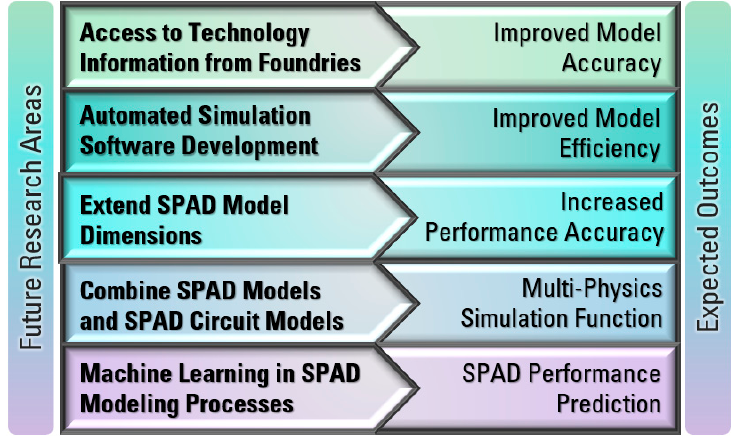
Figure 11. Summary of future research perspectives and potential outcomes.